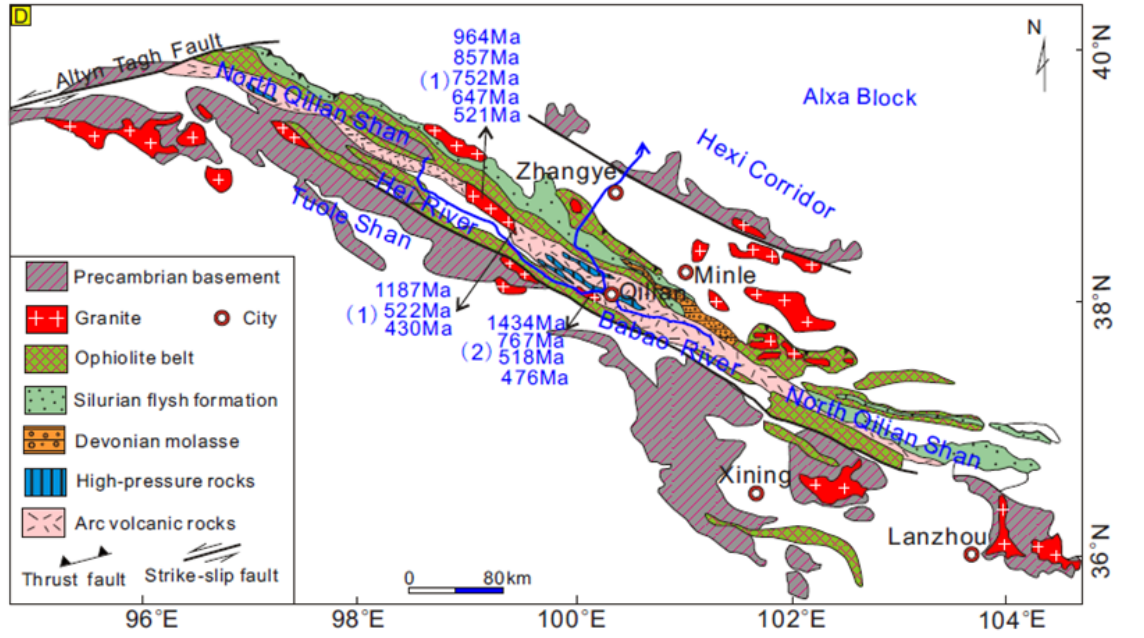
Figure 1. ( A ) Main structural blocks forming the Tibetan Plateau and its surrounding regions (Modified from [33]); ( B ) map showing the major rivers draining the Qilian Shan and adjacent regions. The numbers in white circles refer to published fluvial detrital zircon analysis studies; ( C ) schematic geological cross-section of the a-a ′ trace in Figure 1B (Modified from [16]); ( D ) simplified geological map and granite zircon U-Pb sampling locations along the upper reaches of the Hei River. This map is re-drawn from [6]; Zircon U-Pb ages are from (1) [6,34,35]; (2) [36,37]).